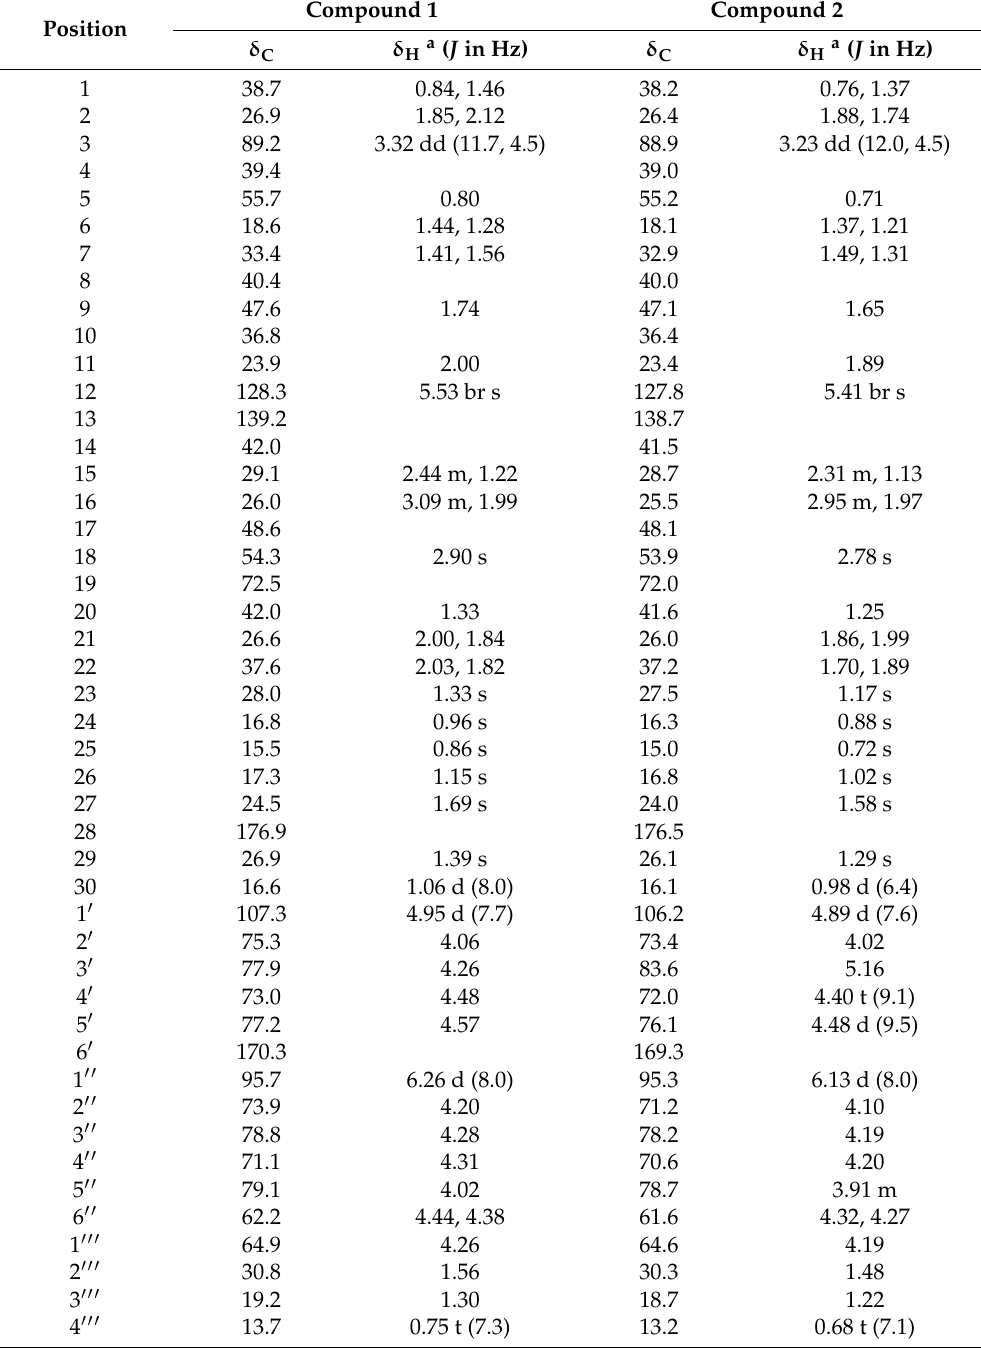
(Figure 2). The correlations of H-3/Me-24, H-5/Me-24, H-5/H-9, H-9/Me-27, OH-19/Me-30 confirmed that these groups were cofacial and α -oriented. Likewise, correlations of Me-23/Me-25, Me-25/Me-26, H-18/Me-26, H-18/Me-29 showed the β -orientation of these groups. The absolute configuration of the aglycone of 1 was presumed to be 3 S , 5 R , 8 R , 9 R , 10 R , 14 S , 17 S , 18 S , 19 R , and 20 R , by the hypothetical biogenetic pathway. Table 1. 1 H- (400 MHz) and 13 C-NMR (100 MHz) spectral data of 1 and 2 in C 5 D 5 N ( δ in